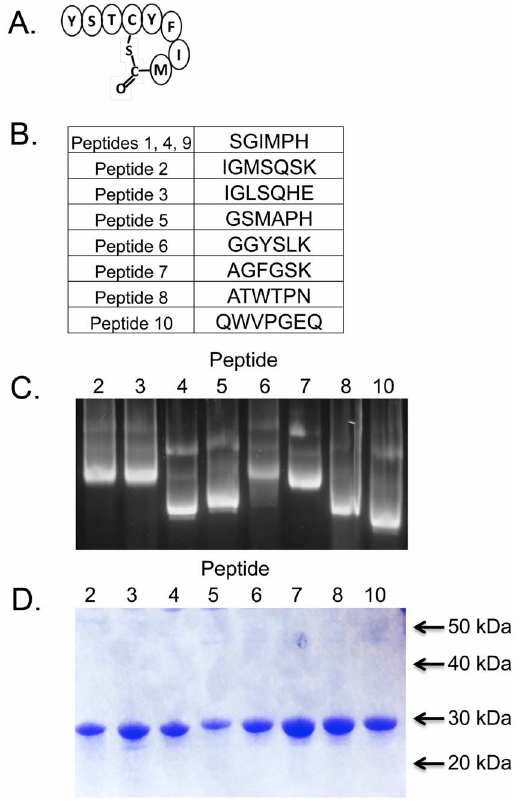
Figure 1. Identification and purification of affinity selected VLP displayed peptides. (A) The sequence and structure of the AIP4 peptide. (B) 10 VLP clones were sequenced after three rounds of VLP affinity selection. Peptide inserts are shown and demonstrate little primary sequence homology to the native AIP4 peptide. (C) Agarose gel analysis of purified VLPs. RNA staining is indicative of intact VLPs (which encapsulate their RNAs) and differences in VLP mobility are mostly due to differences in the charges of the peptides displayed on the VLP surface. (D) SDS-PAGE. Two m g of purified VLP protein were run of a 10% SDS gel and protein was detected by staining the gel using Coomassie Blue.